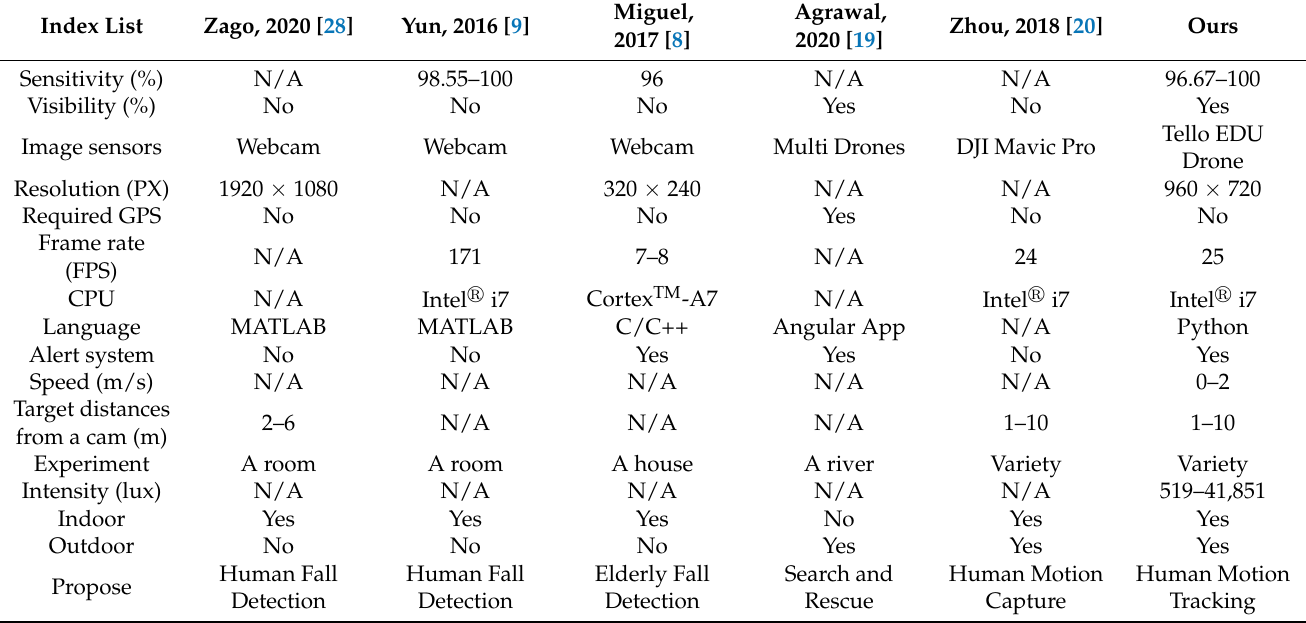
Table 3. Comparison of human motion detection